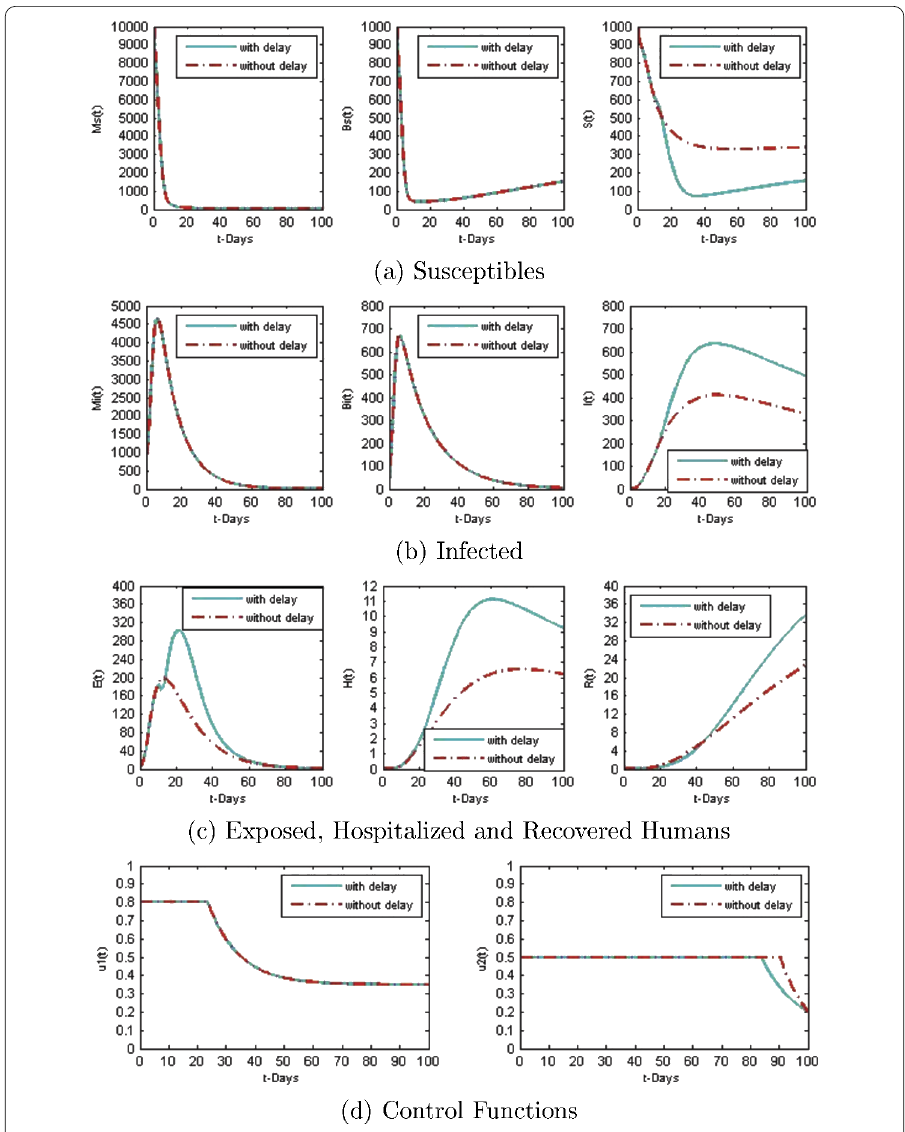
Figure 7 Numerical comparisons of the approximate solutions at d = 10 and d = 0 by using NSFDM. The approximate solutions of the fractional delay optimal control problem at d = 10 and the fraction non-delay optimal control problem at d = 0 when α = 0.98, and (cid:7) t = 0.1